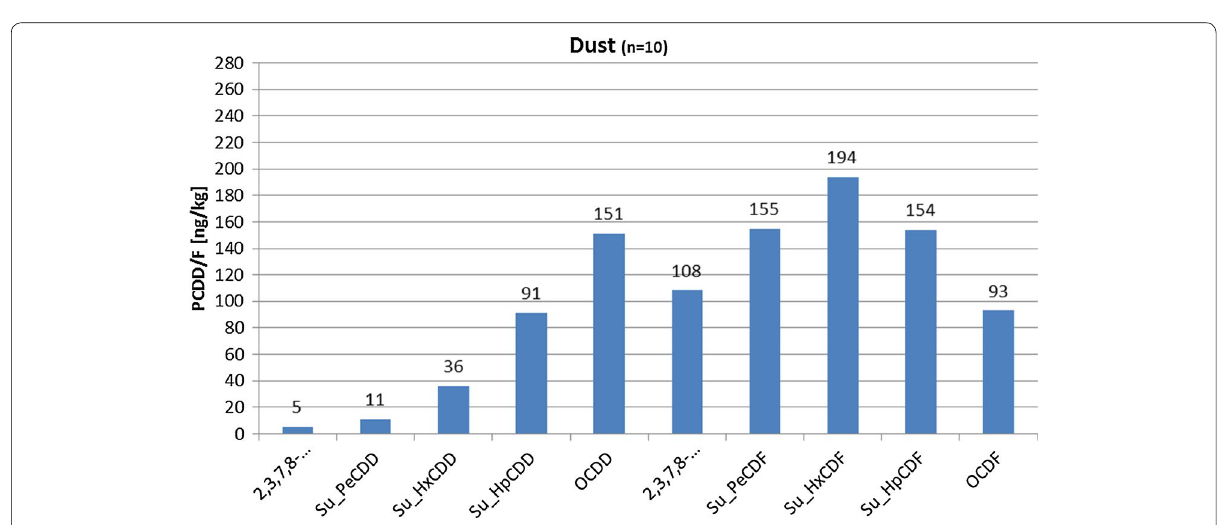
Fig. 8 Homologue pattern of dust (UBA) (Data taken from